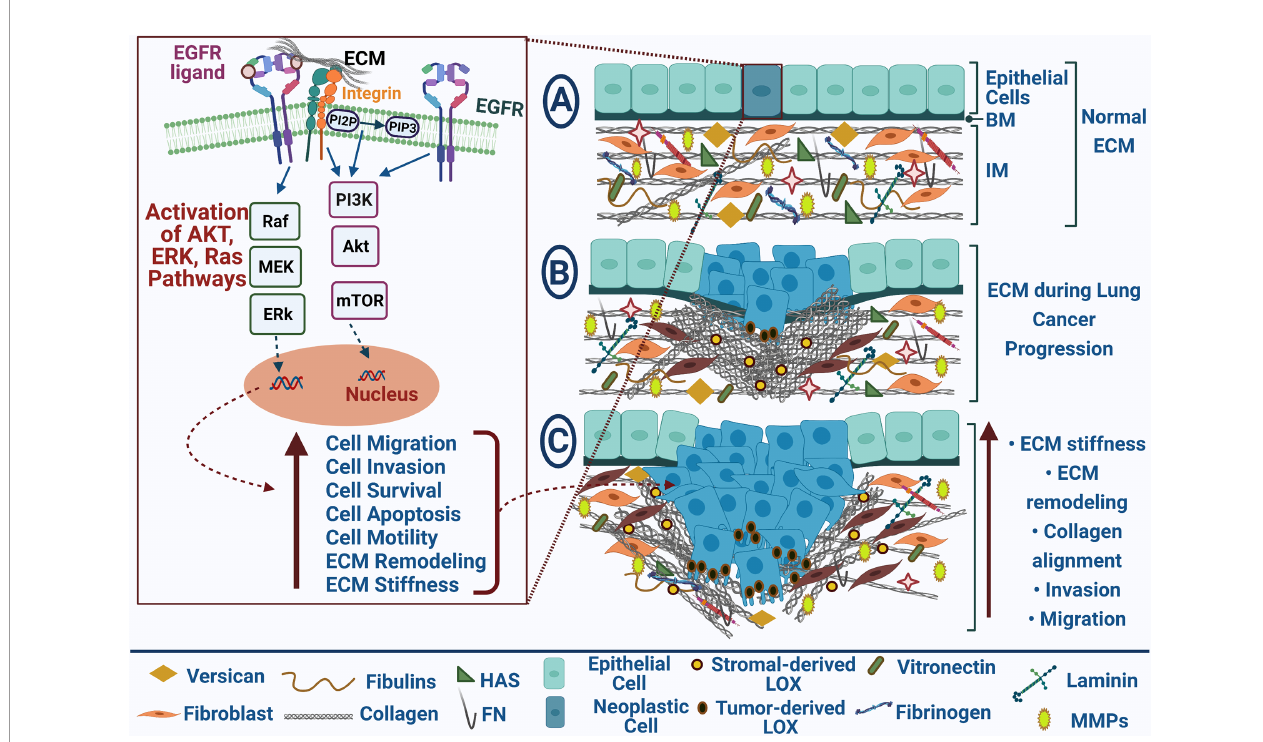
FIGURE 1 | EGFR-mediated ECM remodeling during lung cancer progression. EGFR and ECM receptors, integrins, results in Akt, Erk, and Ras pathways ’ activation that participate in increasing cell migration, invasion, survival, and motility and repressing cell apoptosis; (A) Normal ECM in healthy tissue; (B) Neoplastic cells with uncontrolled cell growth promote ECM remodeling during lung cancer progression; (C) Tumor migration and invasion are mediated by collagen alignment and ECM stiffness. Blue arrows point to stimulation, upright-directed red arrows point to increase effect, and dashed red arrows point to cellular